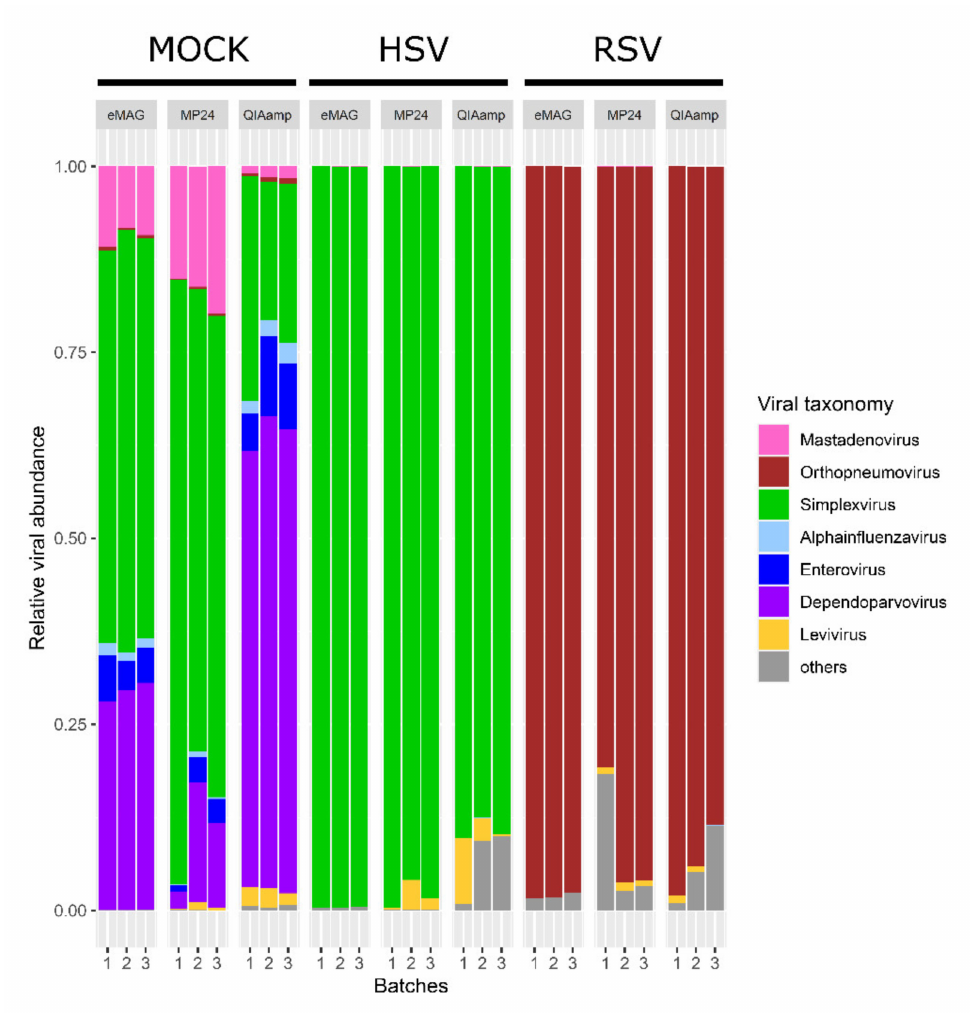
Figure 4. Taxonomic distribution (relative abundance) of triplicates for mock and clinical samples according to the three extraction methods. The relative distribution is described at the genus taxonomic level. Only major viral sequences are illustrated with di ff erent colours. HSV: herpes simplex virus; RSV: respiratory syncytial